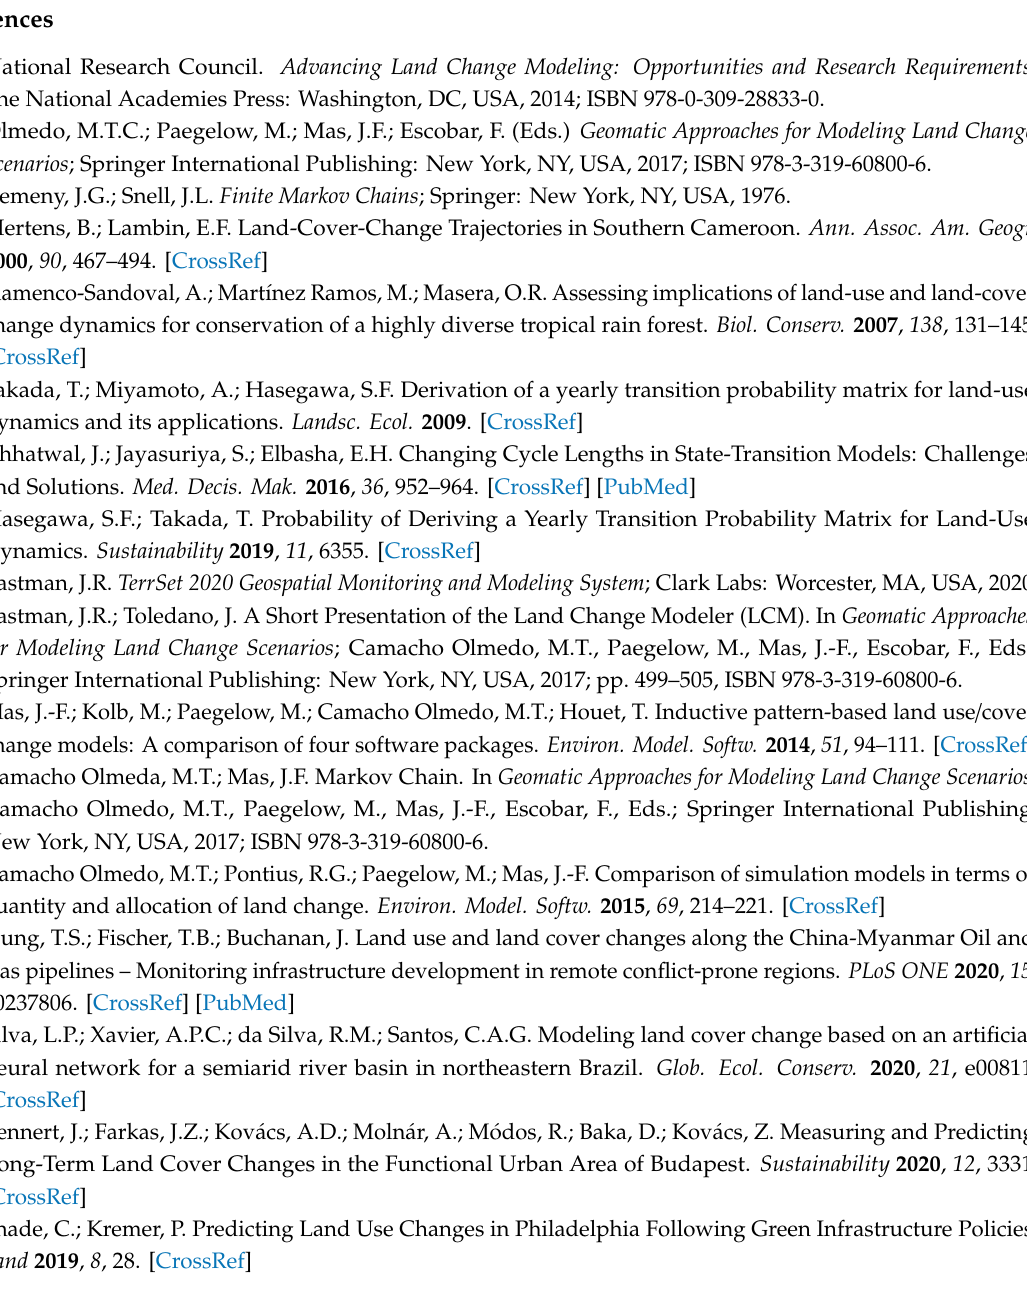
Figure S1: Maximum, mean and median error in transition probability estimation for all 49 transitions in Alabama, USA from 2011 to 2021, Figure S2: Maximum, mean and median error in transition probability estimation for all 49 transitions in Arizona, USA from 2011 to 2021, Figure S3: Maximum, mean and median error in transition probability estimation for all 49 transitions in Delaware, USA from 2011 to 2021, Figure S4: Maximum, mean and median error in transition probability estimation for all 49 transitions in Florida, USA from 2011 to